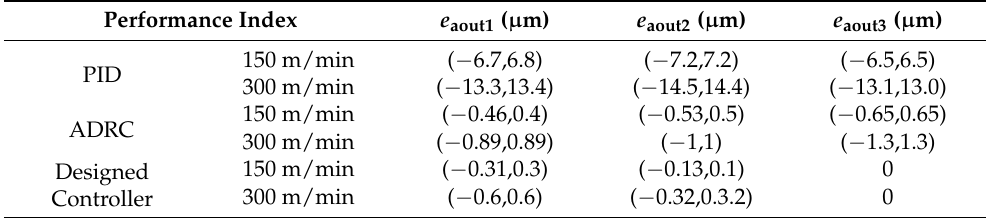
Table 6. Control range of each controller under tension disturbance.